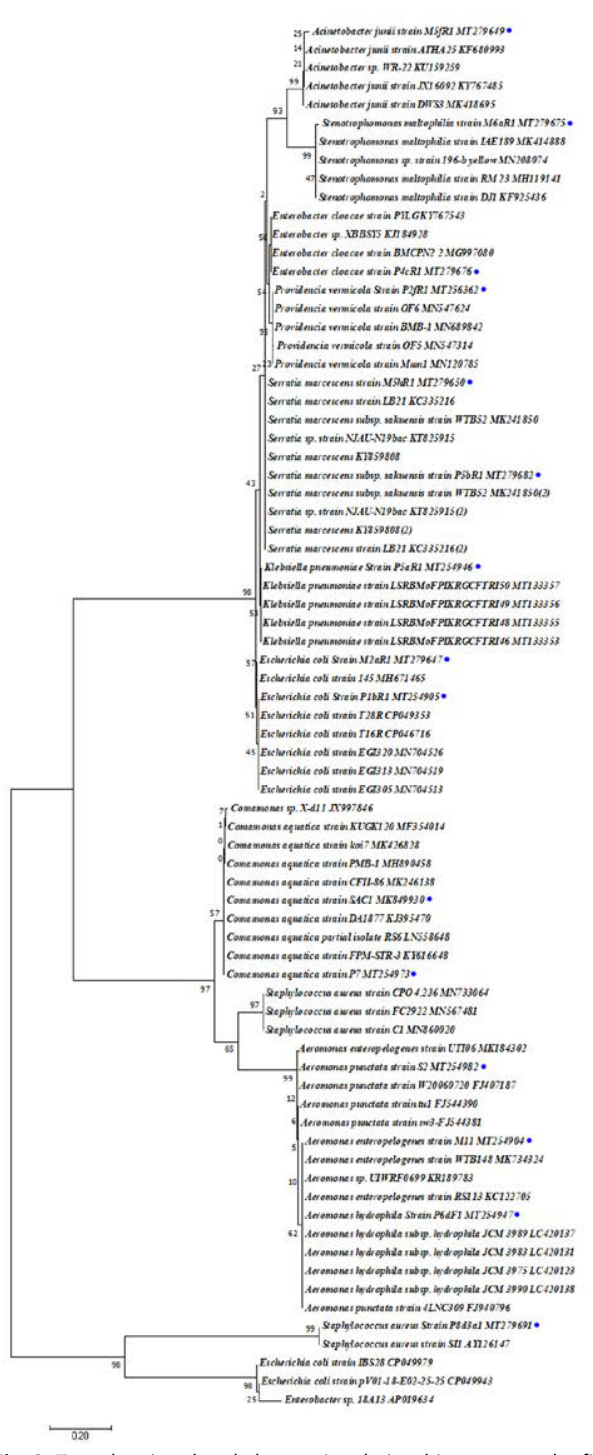
Fig. 2. Tree showing the phylogenetic relationship amongst the fish pathogenic strains. A total of 75 nucleotide sequences were used involving 180 positions in the final